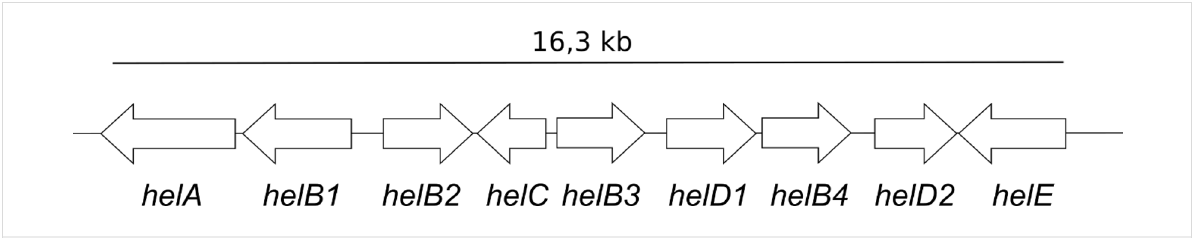
Figure 8: Helvolic acid gene cluster of A.